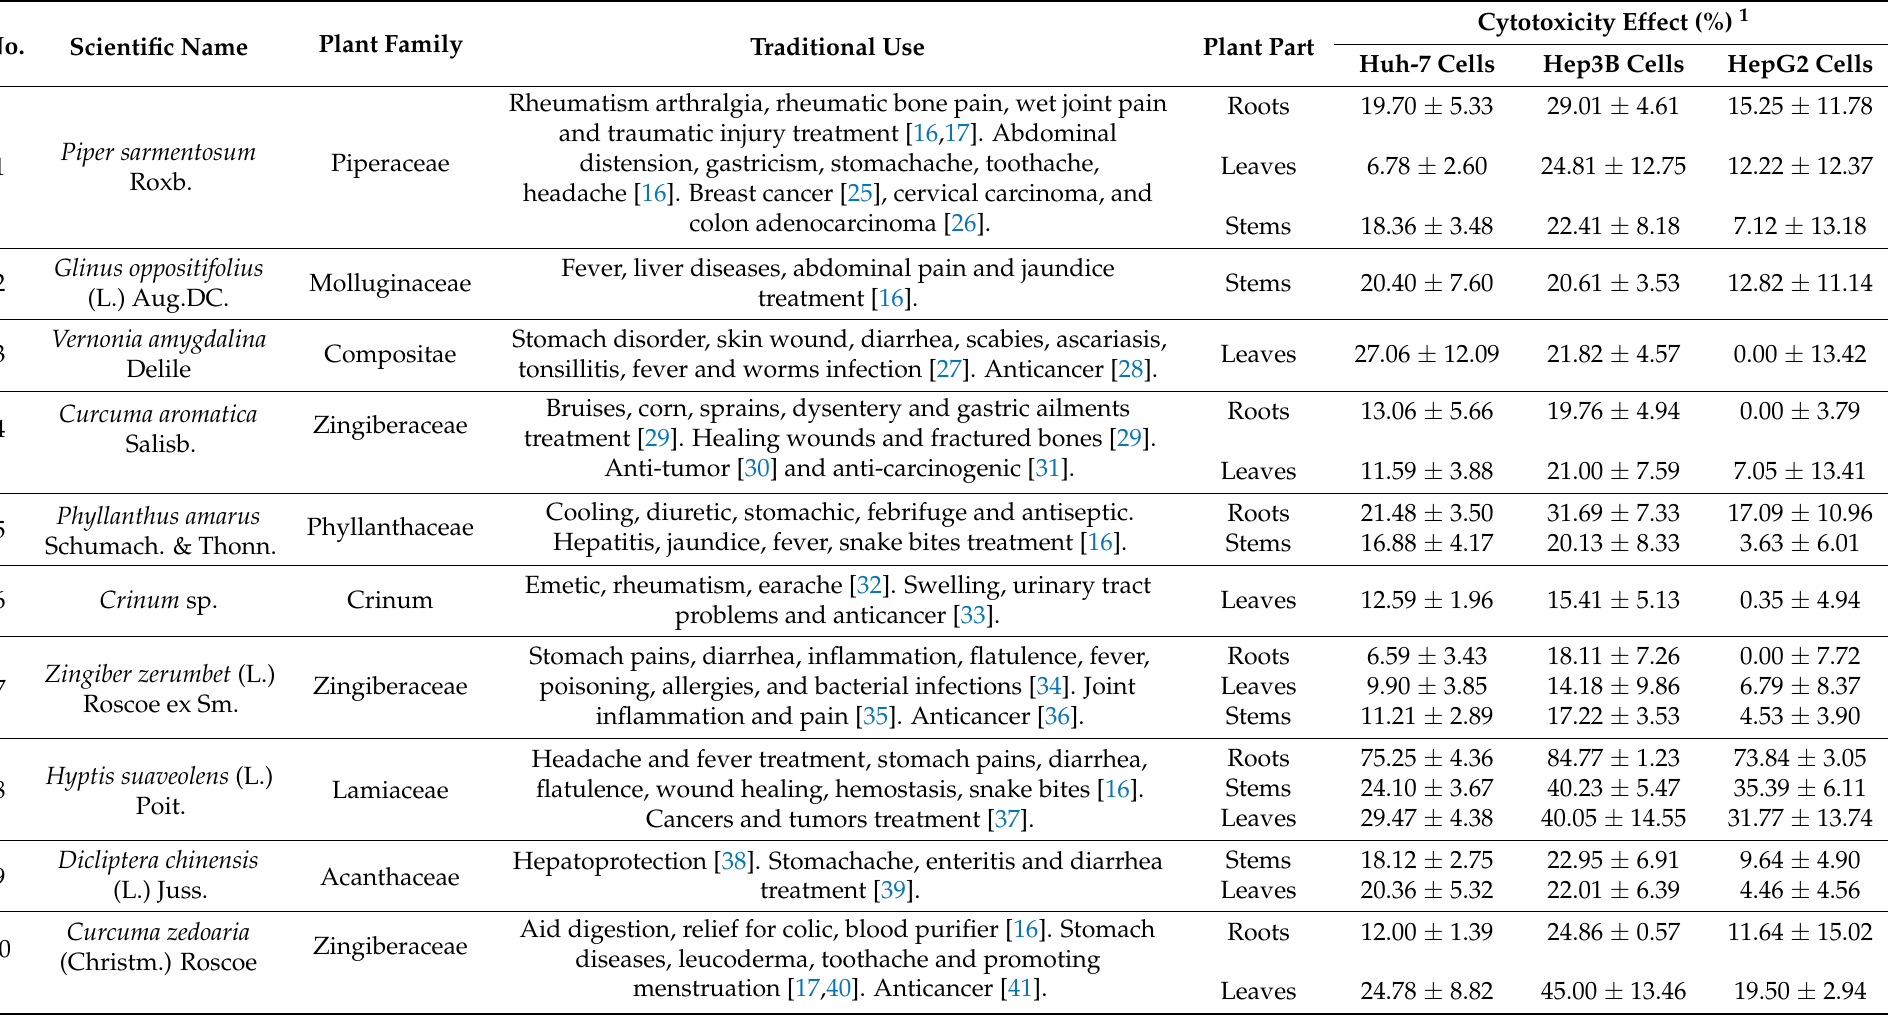
Table 1. In vitro screening of 52 crude methanol extracts from different parts of 24 medicinal herbs for cytotoxicity effect on Huh-7, Hep3B, and HepG2 HCC cells using MTT